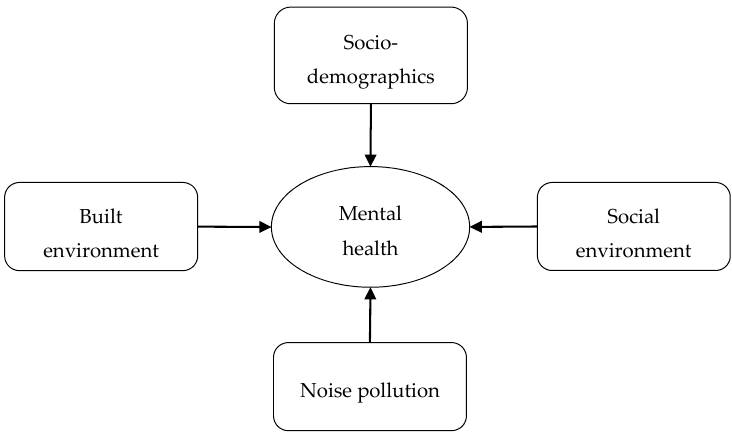
Figure 1. Conceptual framework.